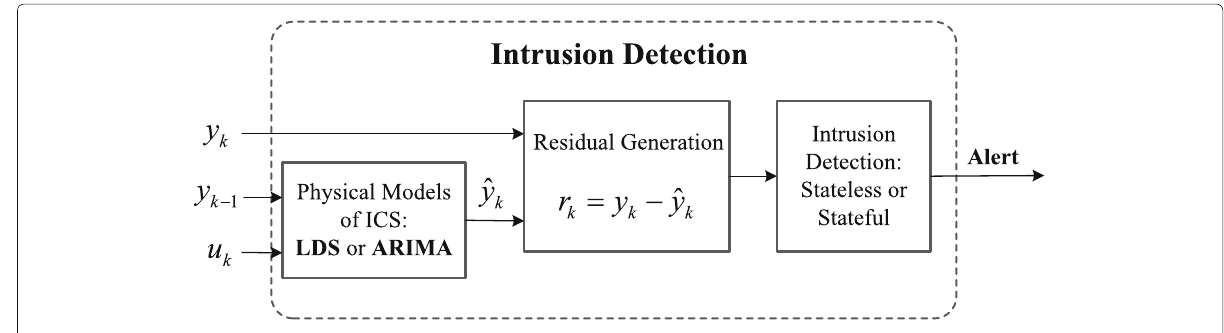
Fig. 1 Intrusion detection based on process data